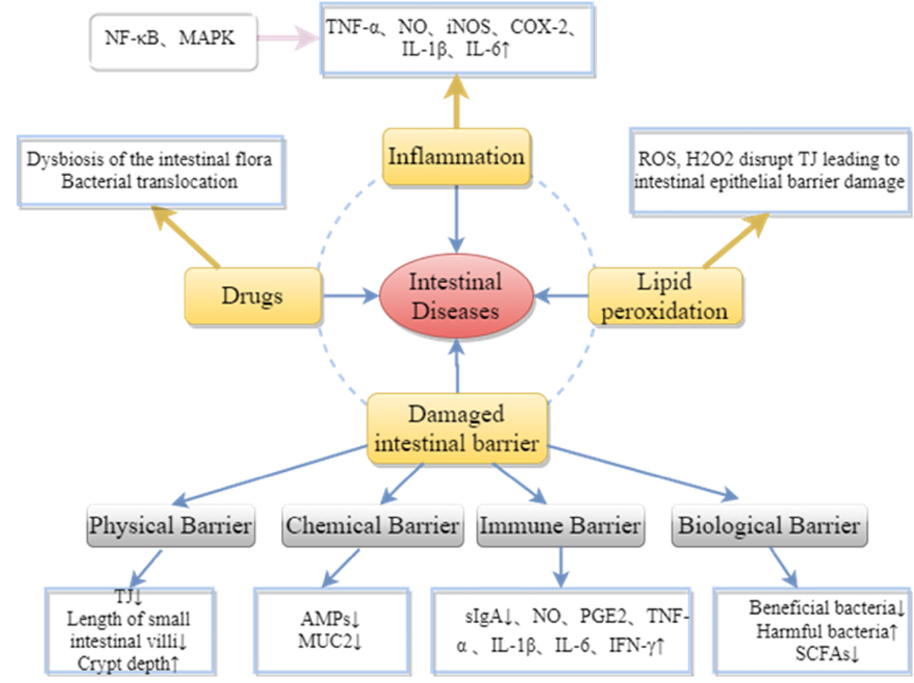
Figure 6. Pathogenesis of intestinal diseases.